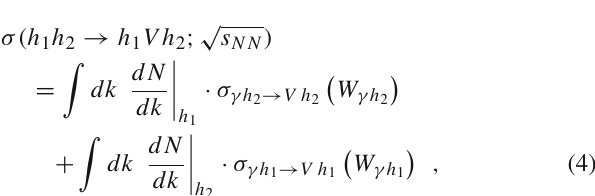
target rest frame is given by